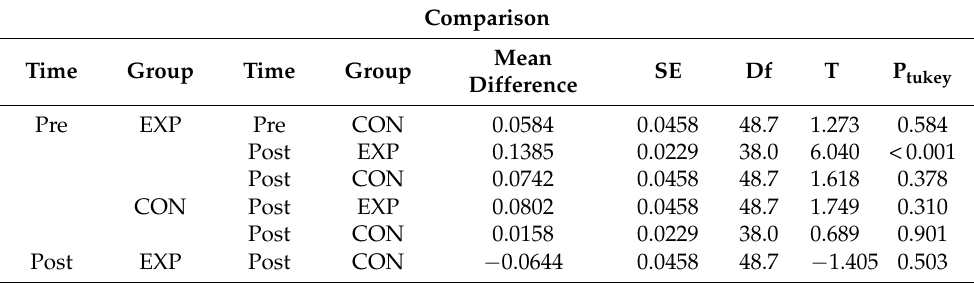
Table 6. Analysis of the Dm parameter post-hoc comparisons—Time *